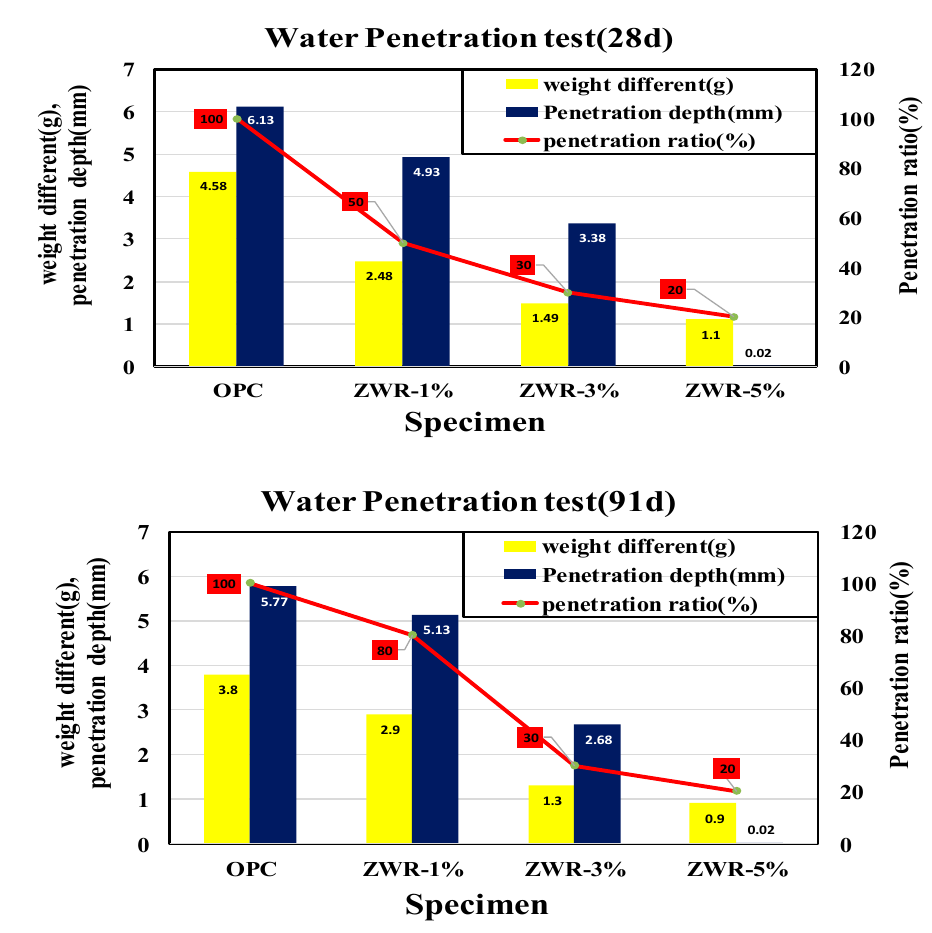
Figure 15. Graph of water penetration test.